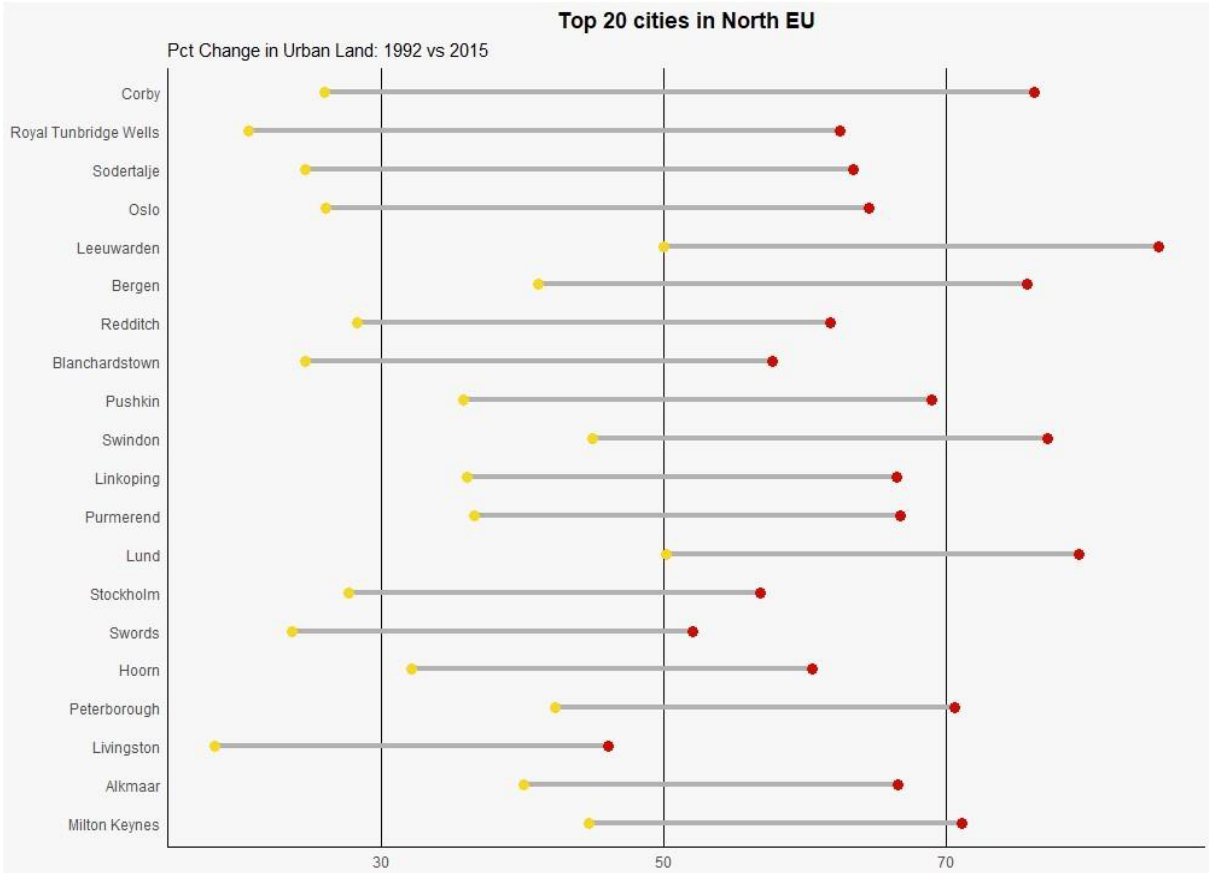
Figure 6. Land use changes in North European cities.